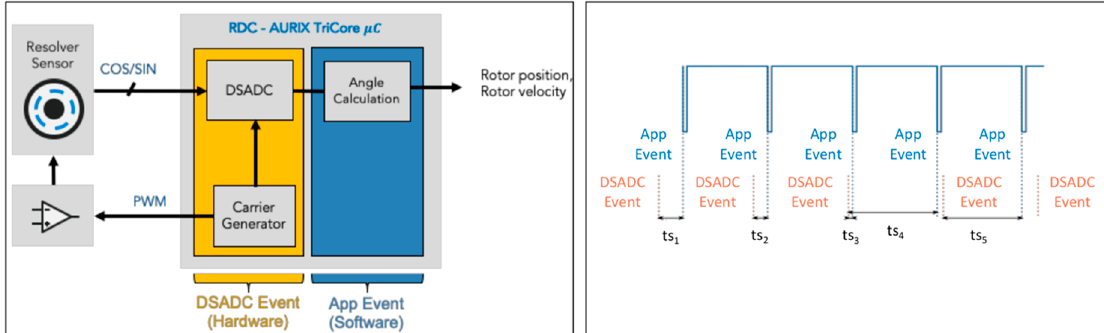
Figure 7. Resolver-to-digital converter (RDC) in the used AURIX TriCore µ C consisting of the two main timing events ( DSADC Event and App Event ). Carrier generator providing a pulse-width modulation (PWM) signal containing the excitation signal information, excitation unit (here an operational amplifier), resolver and delta-sigma-analog-to-digital-converter (DSADC) are operating at f DSADC Event = 9.765 kHz, while the software for angle calculation is operating at f App Event = 9 kHz. The timing behavior of both events and a possible time overtake by the DSADC Event can be seen in the right diagram, where ts n represents the time stamp difference between each related event.